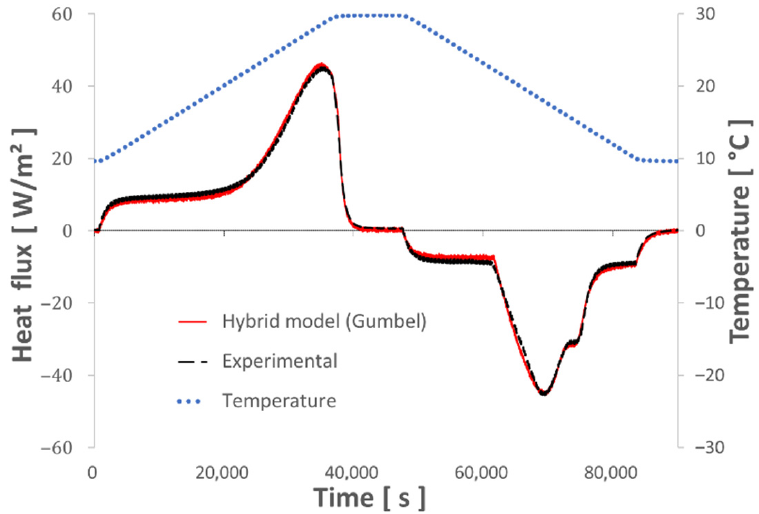
Figure 13. Evolution of the flux exchanged between the plate and the sample (10-h ramp).